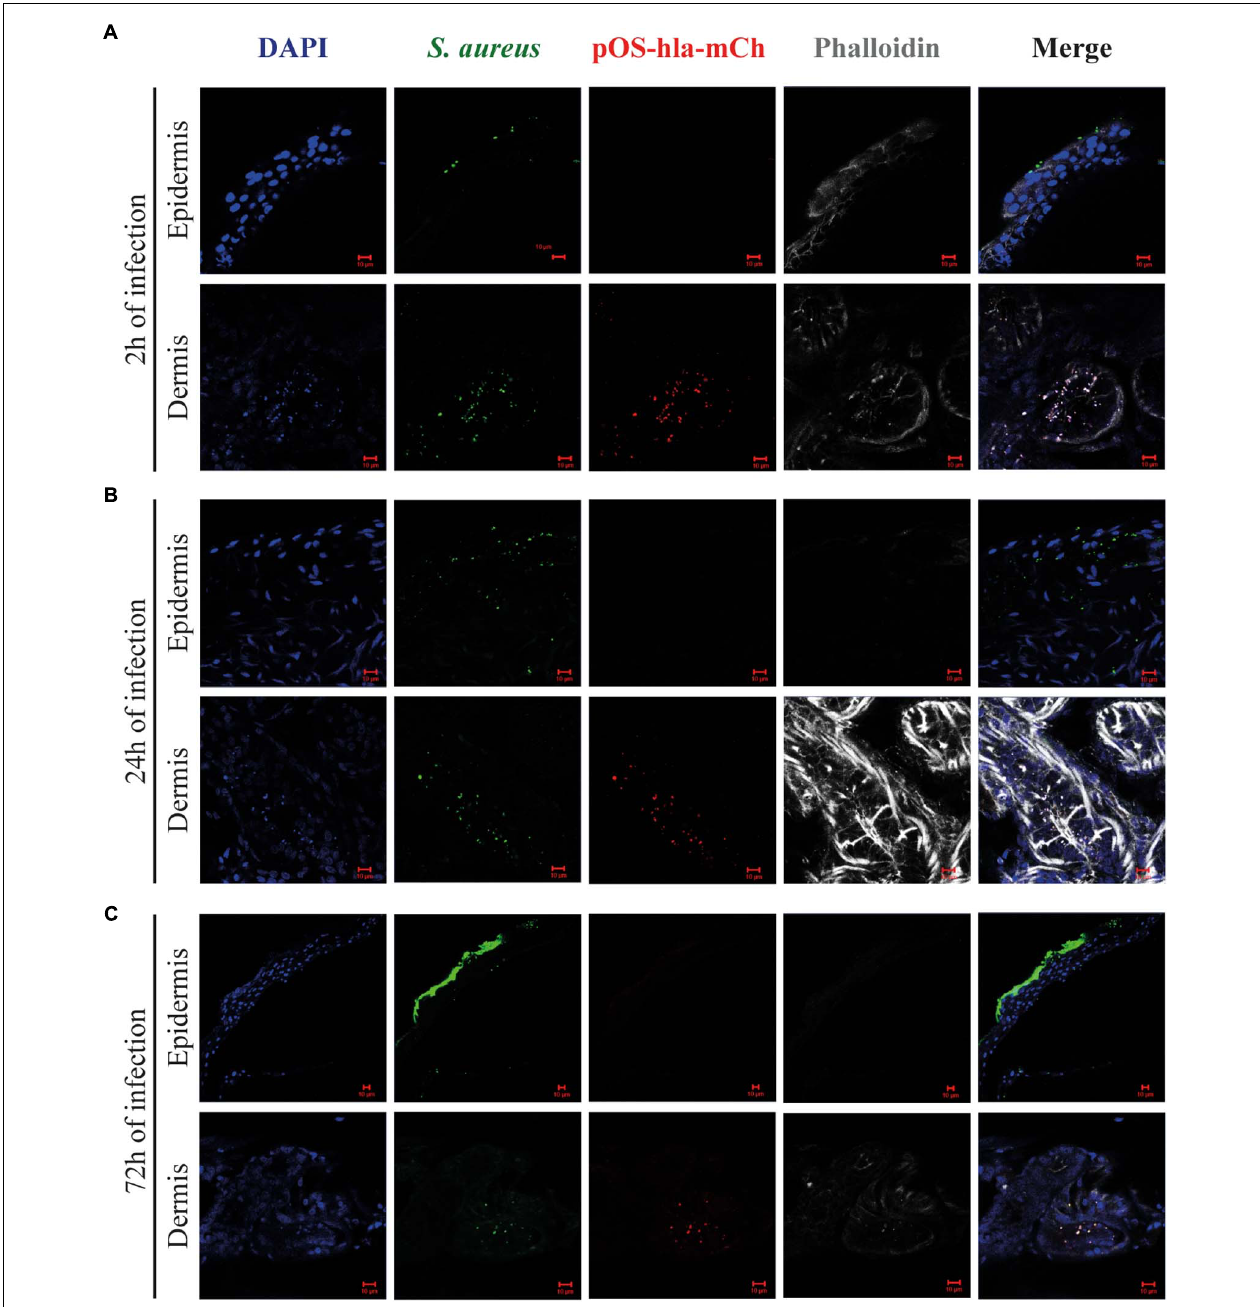
FIGURE 4 | Alpha hemolysin reporter system activation within human skin tissues. Representative images of cryosections of skin infected with S. aureus (pOS-hla-mCherry, red), stained with anti- Staphylococcus aureus antibody (green), phalloidin (gray) and DAPI (blue) after 2 (A) , 24 (B) and 72 h of infection (C) . mages were taken at the epidermis (upper images) and the dermis (lower images) (scale bar, 10 µ